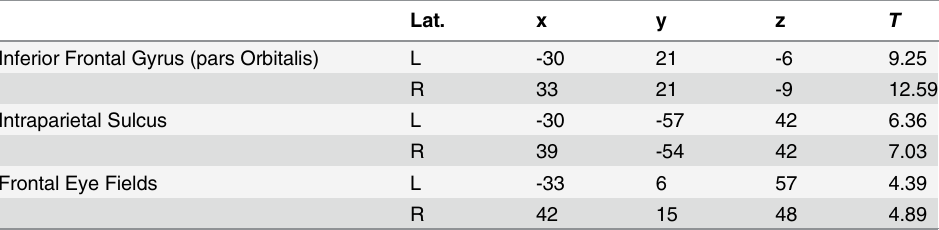
Table 3. Coordinates of defined Regions of Interest (ROIs).